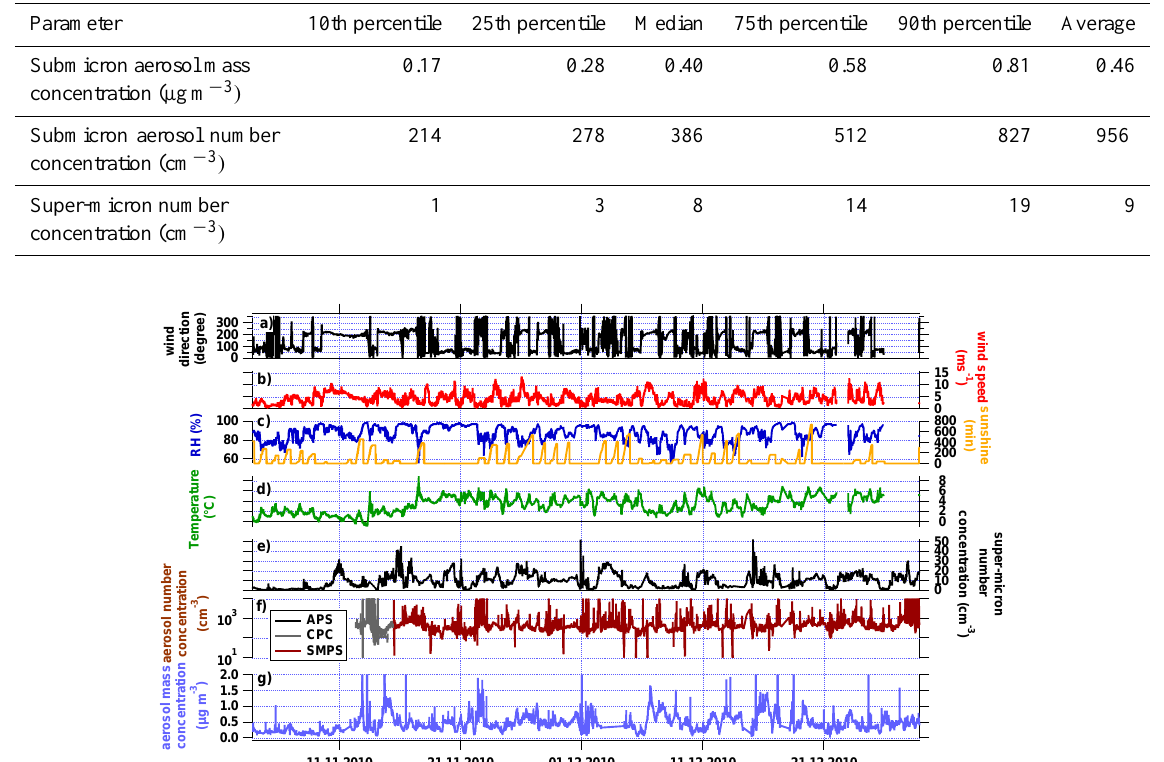
Table 4. Basic statistics of submicron aerosol mass and number concentrations and super-micron particle number concentration (based on 5-minute measurements).